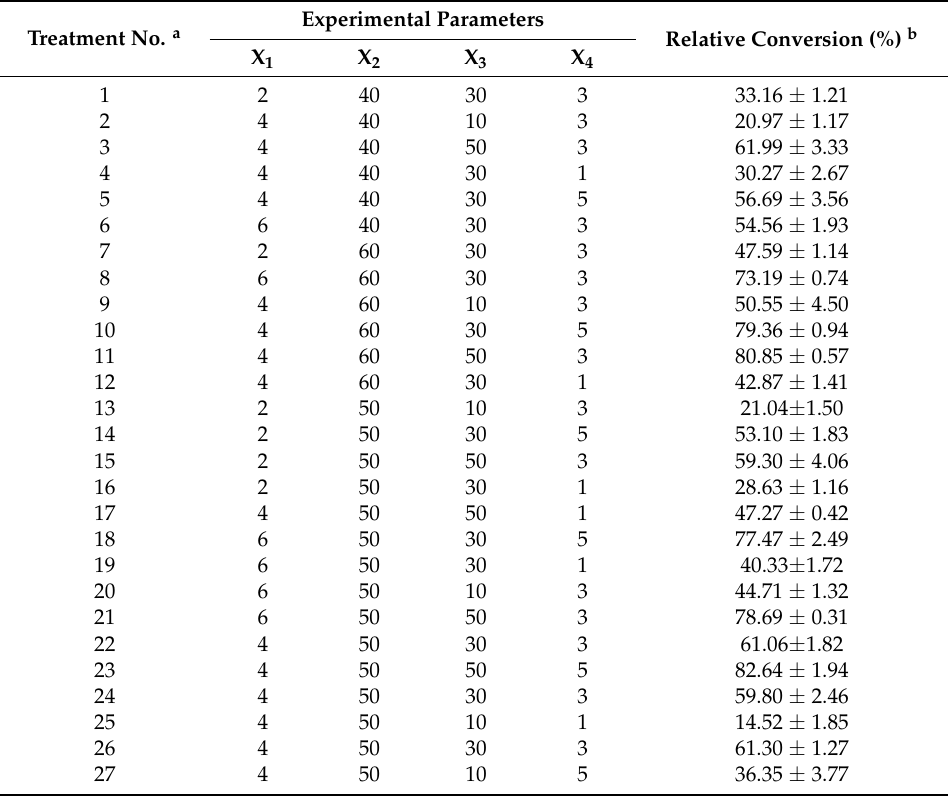
Table 1. Central composite design (CCD) experiments and observed